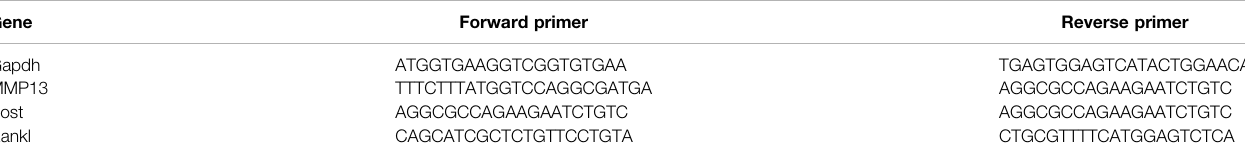
TABLE 1 | Primers used in real-time PCR.